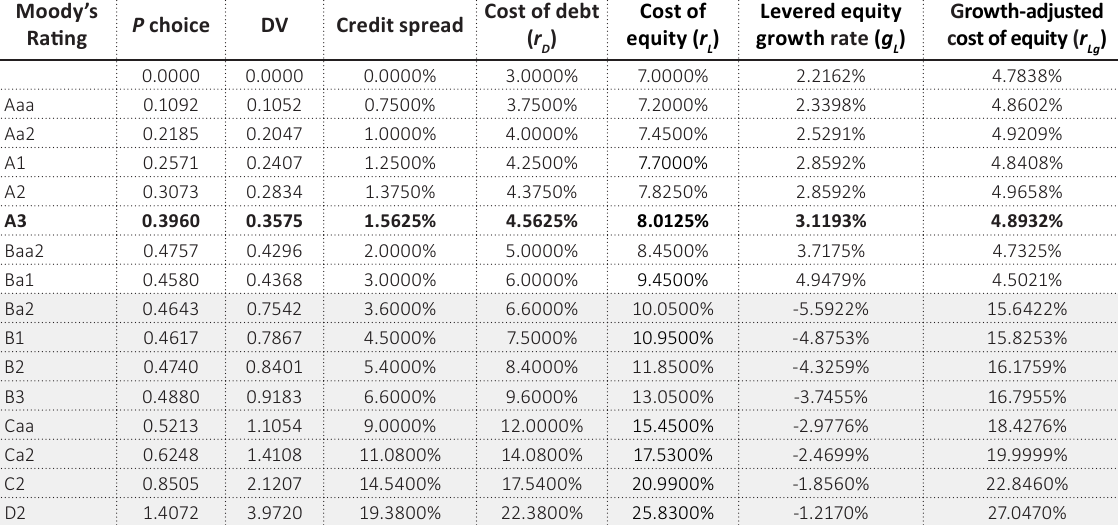
Table 1. Costs of Borrowing for Debt and Equity Matched to Credit Ratings As described in this section, this table reports outcomes for eight variables for a test where a large growth firm targets a Moody’s rating of A3. This is one of our fifteen tests for which results are reported later in Table 2 . A P choice is the proportion of unlevered equity ( E debt and DV is the debt-to-firm value ratio. The bold print row contains the optimal outcomes. Thus, the target A3 rating is also the OTR . The gray shaded rows indicate that the RE (growth) constraint given by Hull ( 2018 ) is violated and so outcomes in these rows are not feasible. For the first row, the costs of borrowing are actually unlevered outcomes. For example, r the “U” refers to unlevered outcome. All other rows supply levered